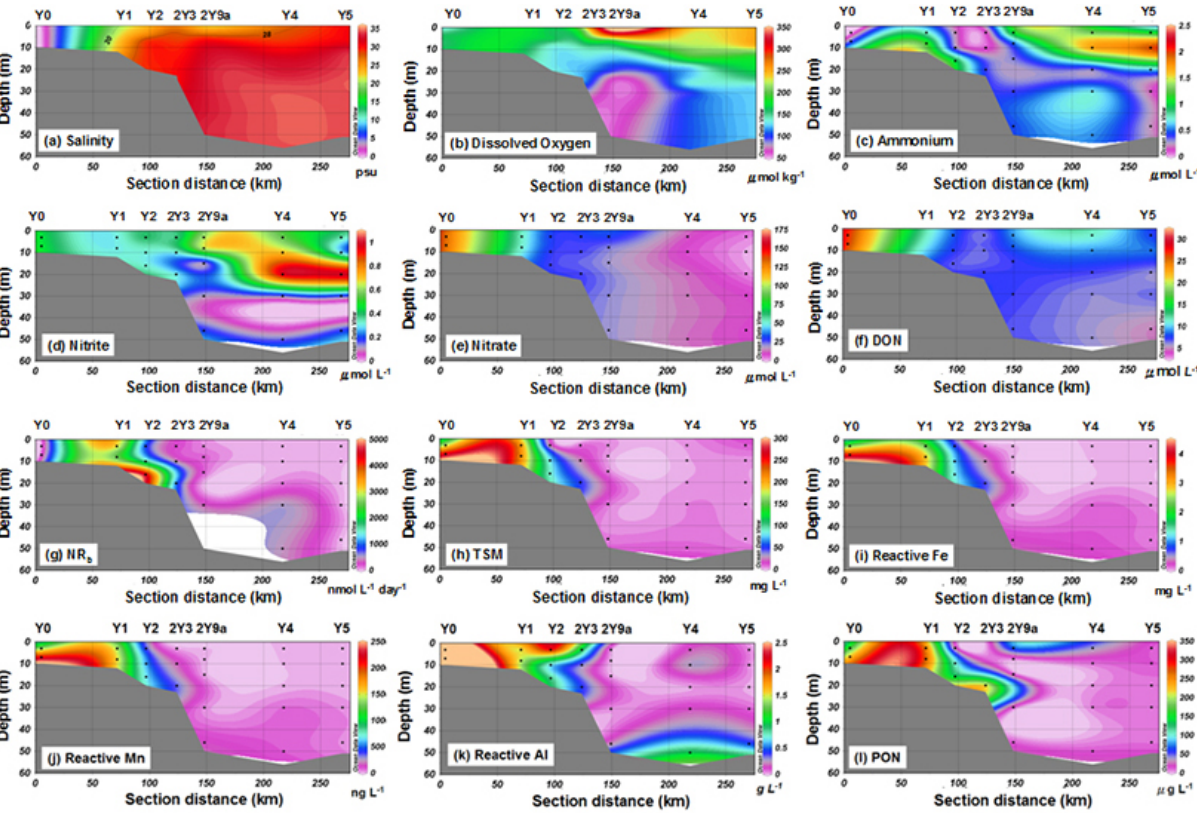
Fig. 2. Transects of (a) salinity, (b) dissolved oxygen, (c) ammonium, (d) nitrite, (e) nitrate, (f) dissolved organic nitrogen (DON), (g) bulk nitrification rate (NR b ), (h) total suspended material (TSM), (i) reactive Fe, (j) reactive Mn, (k) reactive Al, (l) and particulate organic nitrogen (PON) across the Chang Jiang plume. Salinity and dissolved oxygen were obtained continuously by CTD. Discrete sampling depths of other parameters are indicated by black dots. Data were plotted using the DIVA gridding in ocean data view v.4.3.2 (http://odv.awi.de,